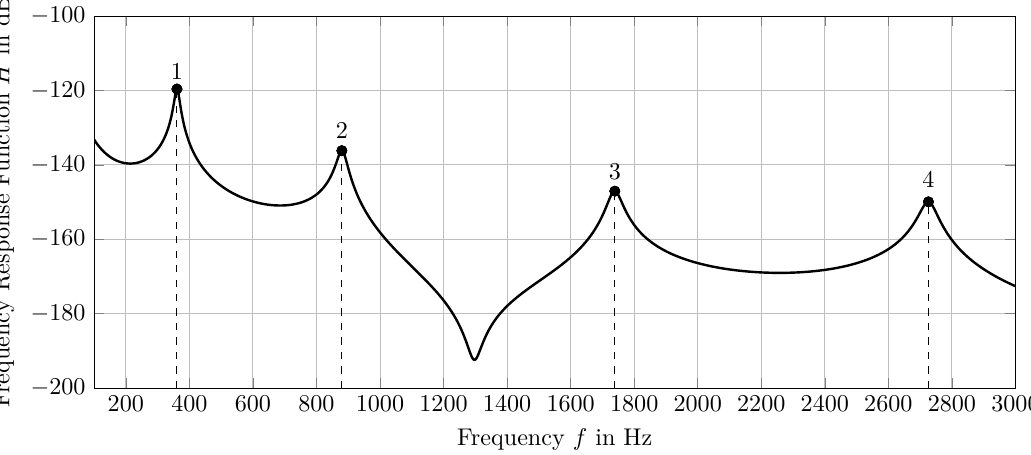
Figure 5. Reference FRF curve of the numerical